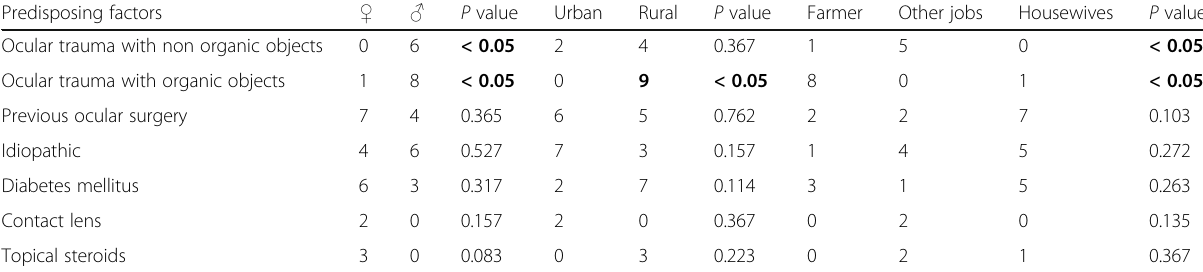
Table 2 Distribution of predisposing factors according to occupation, sex, and residence Predisposing factors